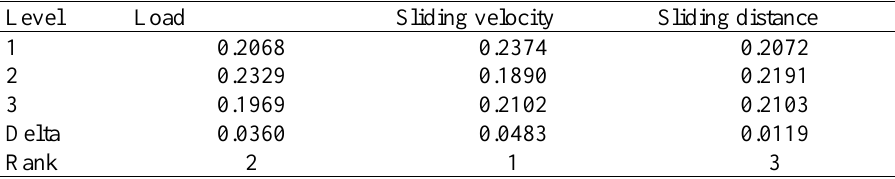
Table 10. Main effects on grey relational grades.